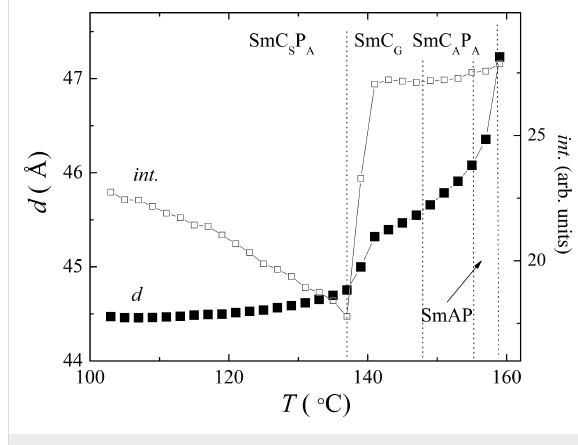
Figure 6: Switching current for compound IIb at T = 150 °C, taken in the SmC A P A phase at a triangular field, E , at a frequency of 12 Hz.